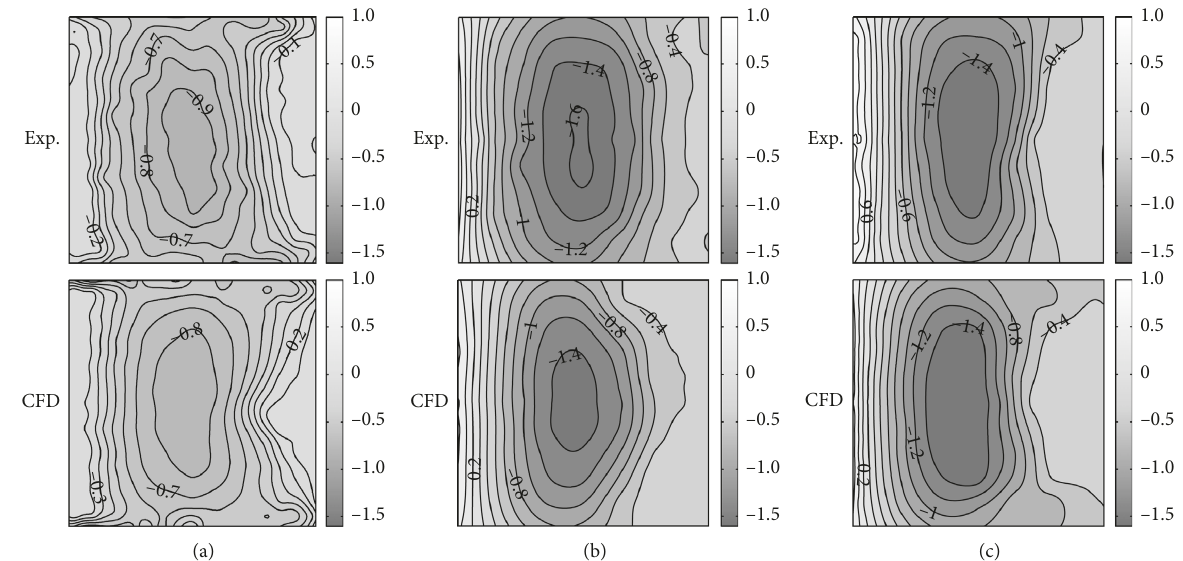
Figure 7: Numerical results of contours of mean pressure coefficients on cylindrical roofs in comparison with experimental results. (a) R / S � 1/6. (b) R / S � 1/3. (c) R / S � 1/2.